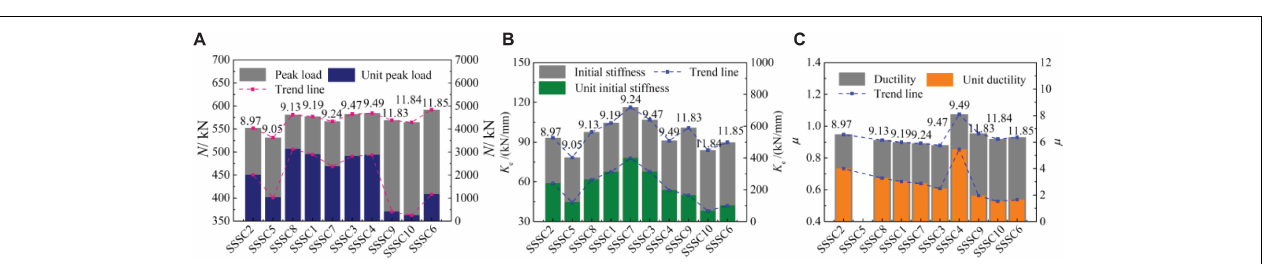
Frontiers in Materials |